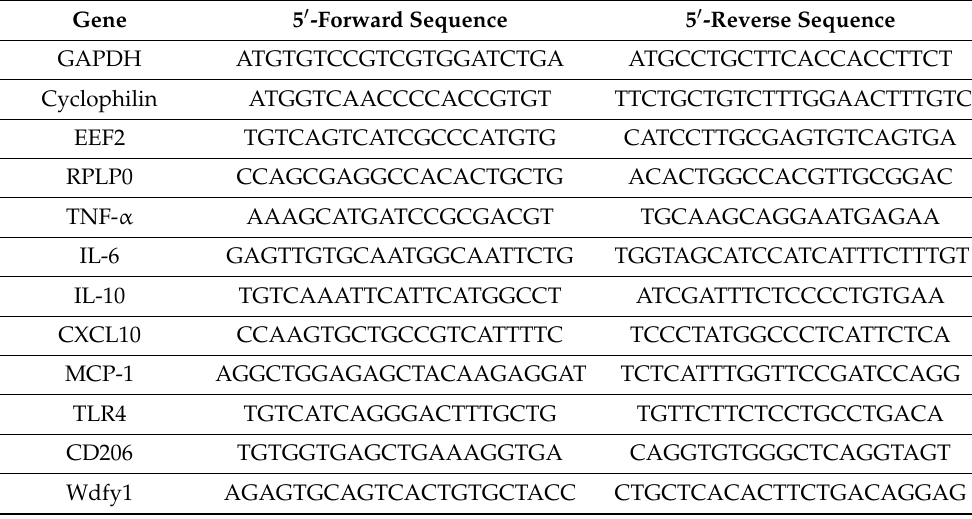
Table 1. Primer sequences used in qPCR